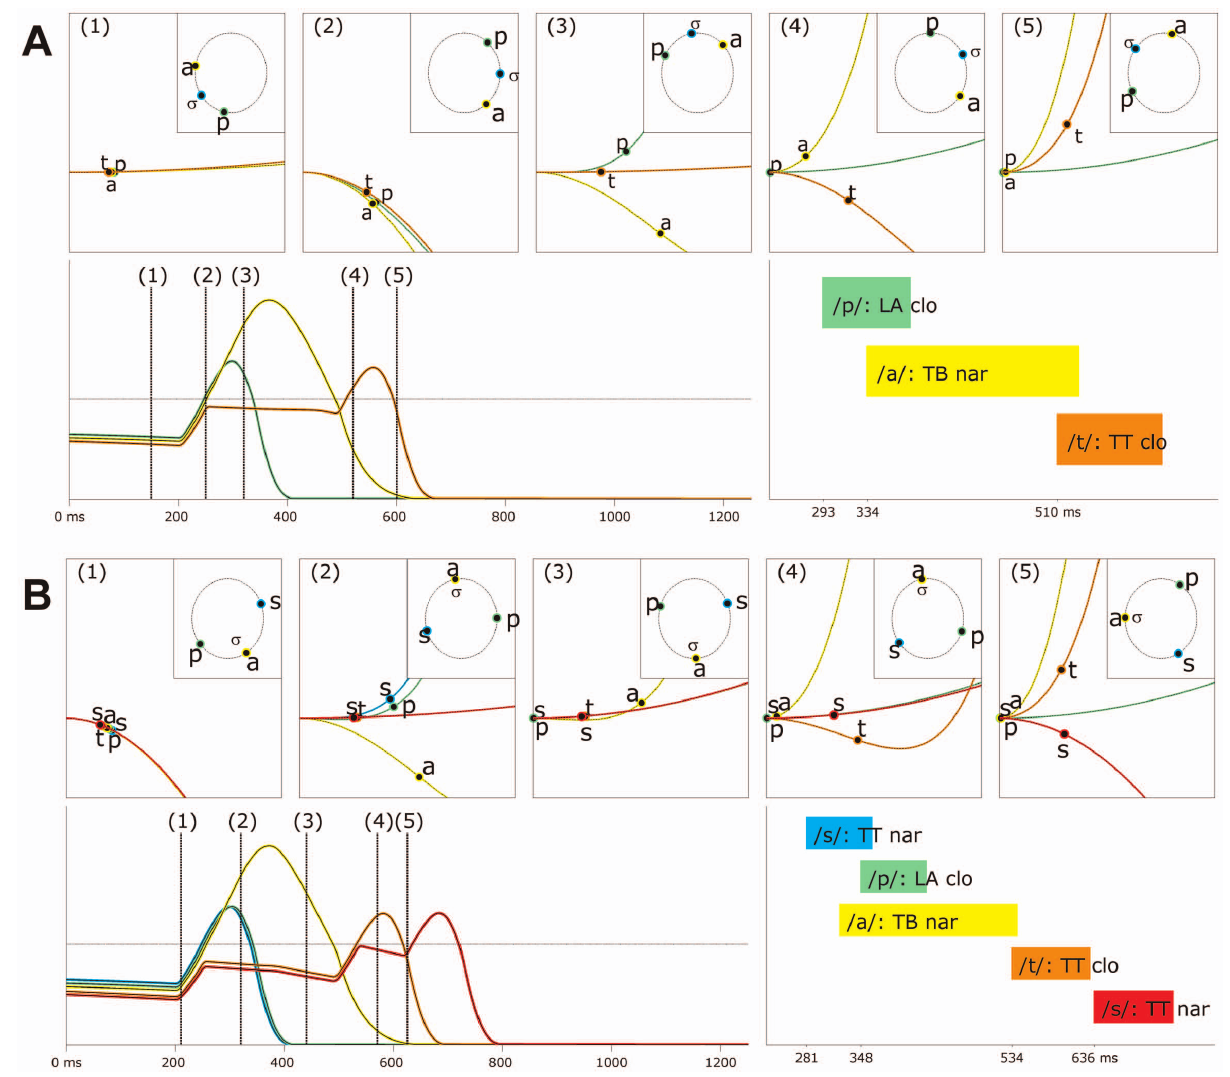
Figure 7. Simulations of onset/coda asymmetry and complex onsets/codas. (A) a CVC form ‘‘pot’’. (B) a CCVCC form ‘‘spots’’. Top rows of panels show potential functions and phases from a sequence of five stages in the planning of the utterance. Bottom rows of panels show activation variables and gestural driving functions.